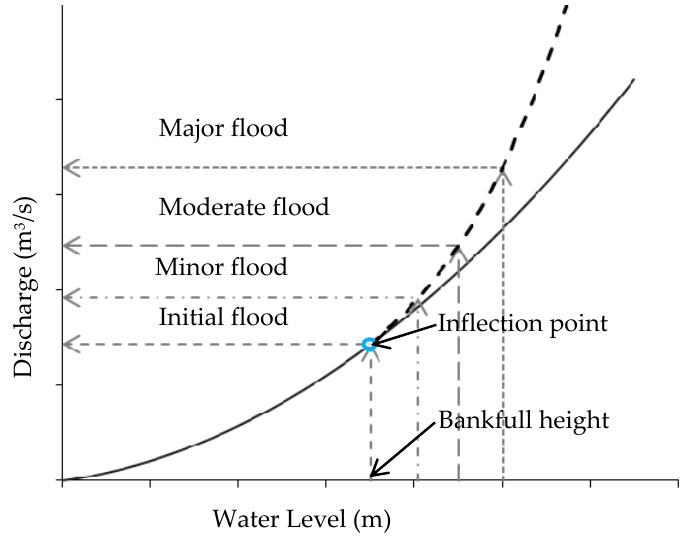
Figure 2. A streamflow rating curve showing flood categories for a typical river. An initial flood is defined as the bankfull (BF) discharge when the river starts flowing over bank.